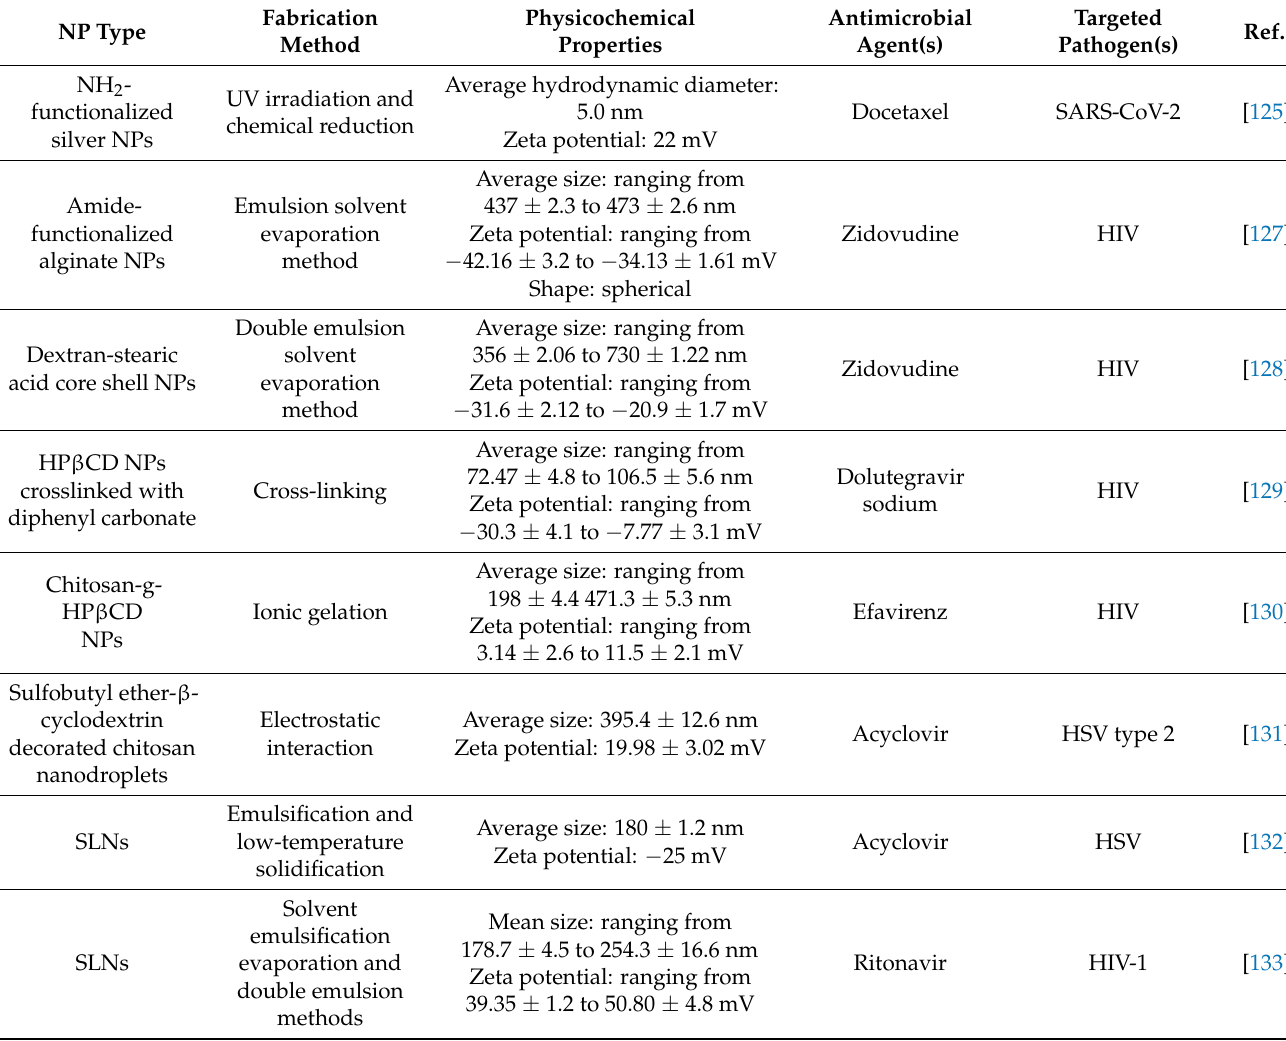
Table 4. Examples of antiviral